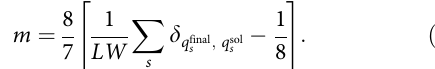
Methods section we show explicitly that along the classical axis, d ¼ D / K ¼ 0, the vertex model displays no finite temperature bulk thermodynamic transition irrespective of the computational circuit it represents. In particular, the resulting bulk thermo- dynamic behaviour is always that of a paramagnet: